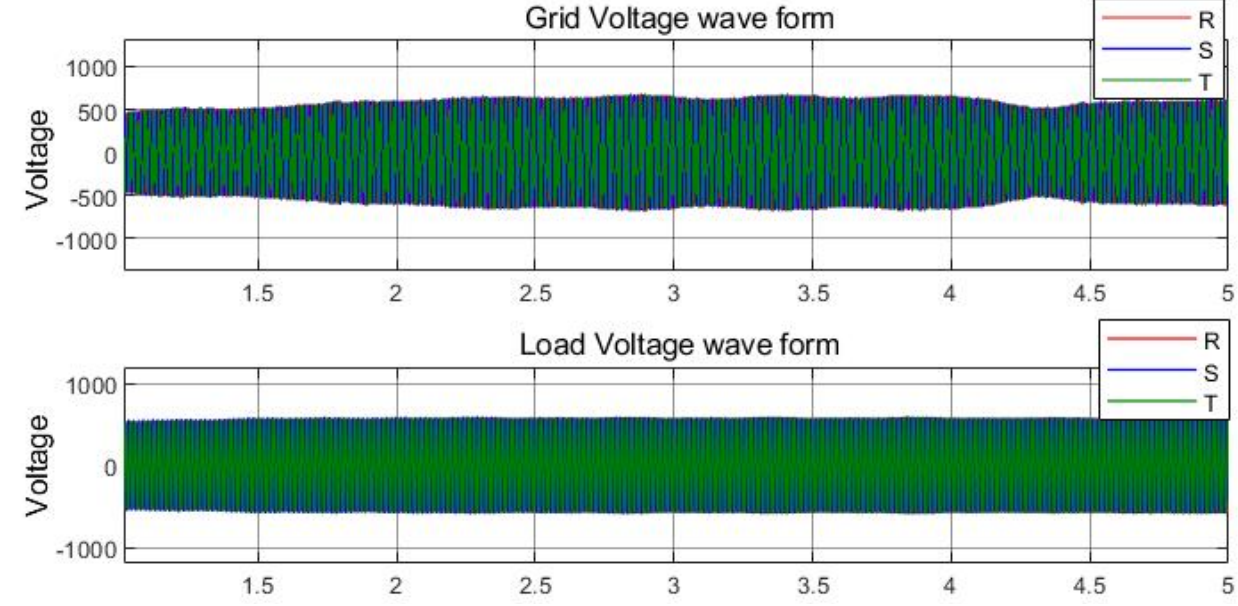
Figure 21. Load-side voltage and grid-side voltage amplitude with non-linear load on the load side using hysteresis.